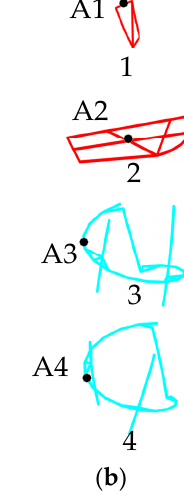
Figure 4. Measurement point layout and section of different measurement points for calculating β i ( z ): ( a ) Measurement point layout, ( b ) Section division of different measurement points.